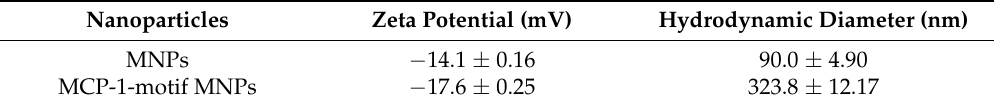
Table 3. Dynamic light scattering (DLS) results of MNPs and MCP-1-motif MNPs ( n = 3).